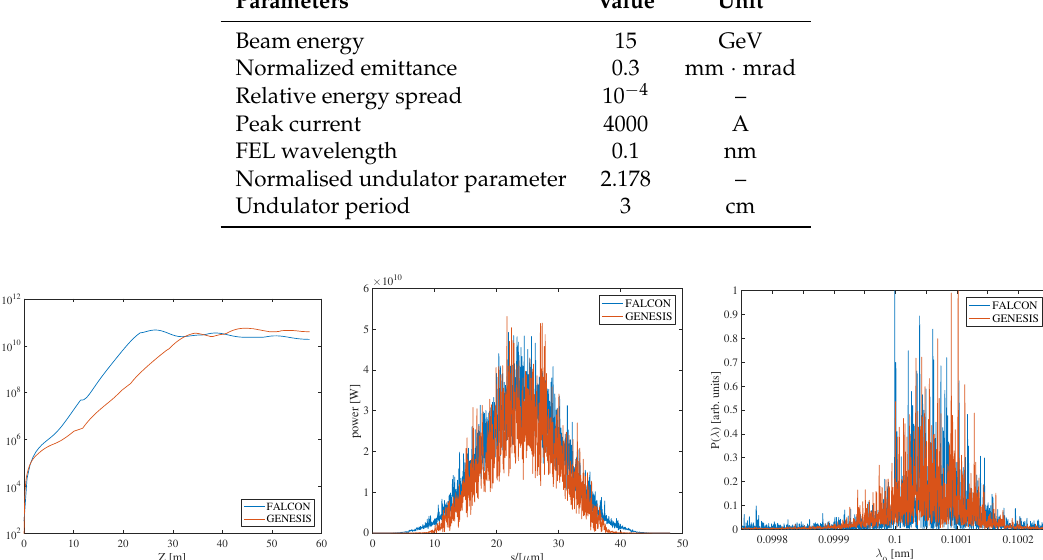
Figure 2. Comparison of the SASE simulation results with FALCON (blue) and GENESIS 1.3 (red), both of them are time-dependent simulation results. (left: the evolution of FEL power; mid: longitudinal power profile; right: spectrum at